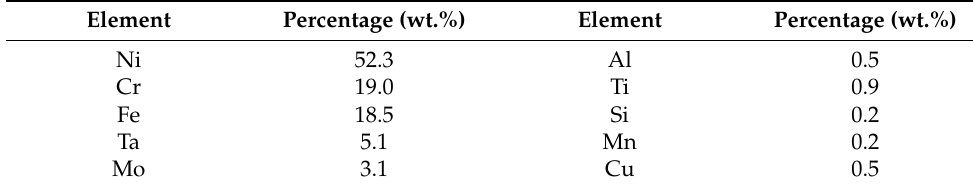
Table 1. Chemical composition of the commercial Inconel 738 used as the substrate for APS deposition of HEA coatings.